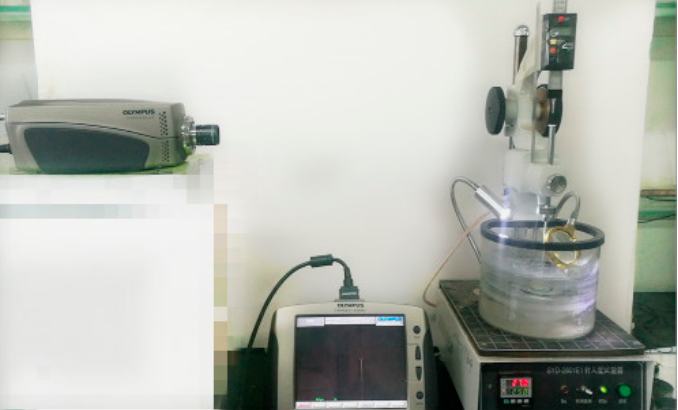
Figure 2. The penetration test process recorded by the high-speed camera.